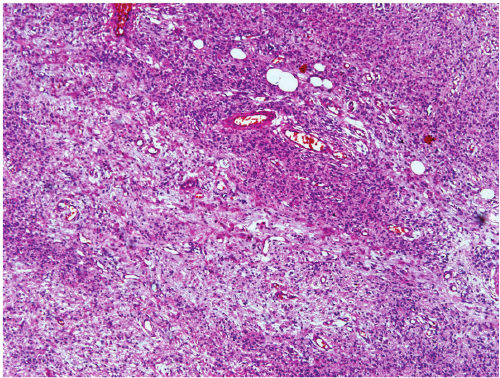
Figure 3: Fibrocellular connective tissue predominantly elongated spindle shaped with wavy and bent